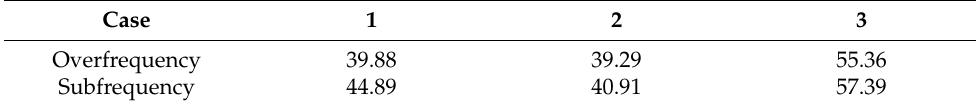
Figure 12. Rate of change of frequency during a sub-frequency event.